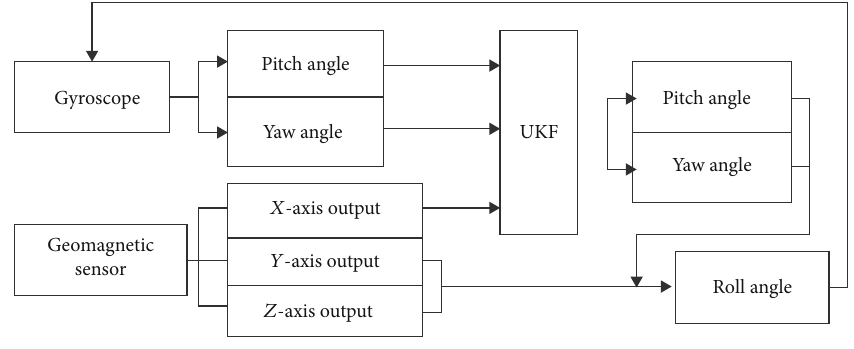
Figure 3: Filtering